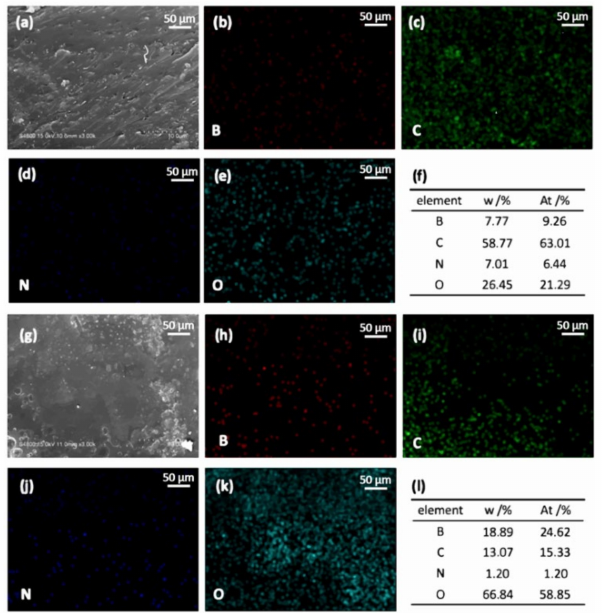
Figure 9. Micro morphology and energy spectrum analysis of BPh-Q 10 thermosets before and after thermal oxidation treatment, ( b – e ) the corresponding EDS elemental mapping images before thermal oxidation treatment, ( a , g ) SEM of BPh-Q 10 thermosets before and after thermal oxidation treatment, ( f , l ) the mass percentage of the surface element before and after thermal oxidation treatment and ( h – k ) the corresponding EDS elemental mapping images after thermal oxidation treatment. The gold spray time was 30 s.